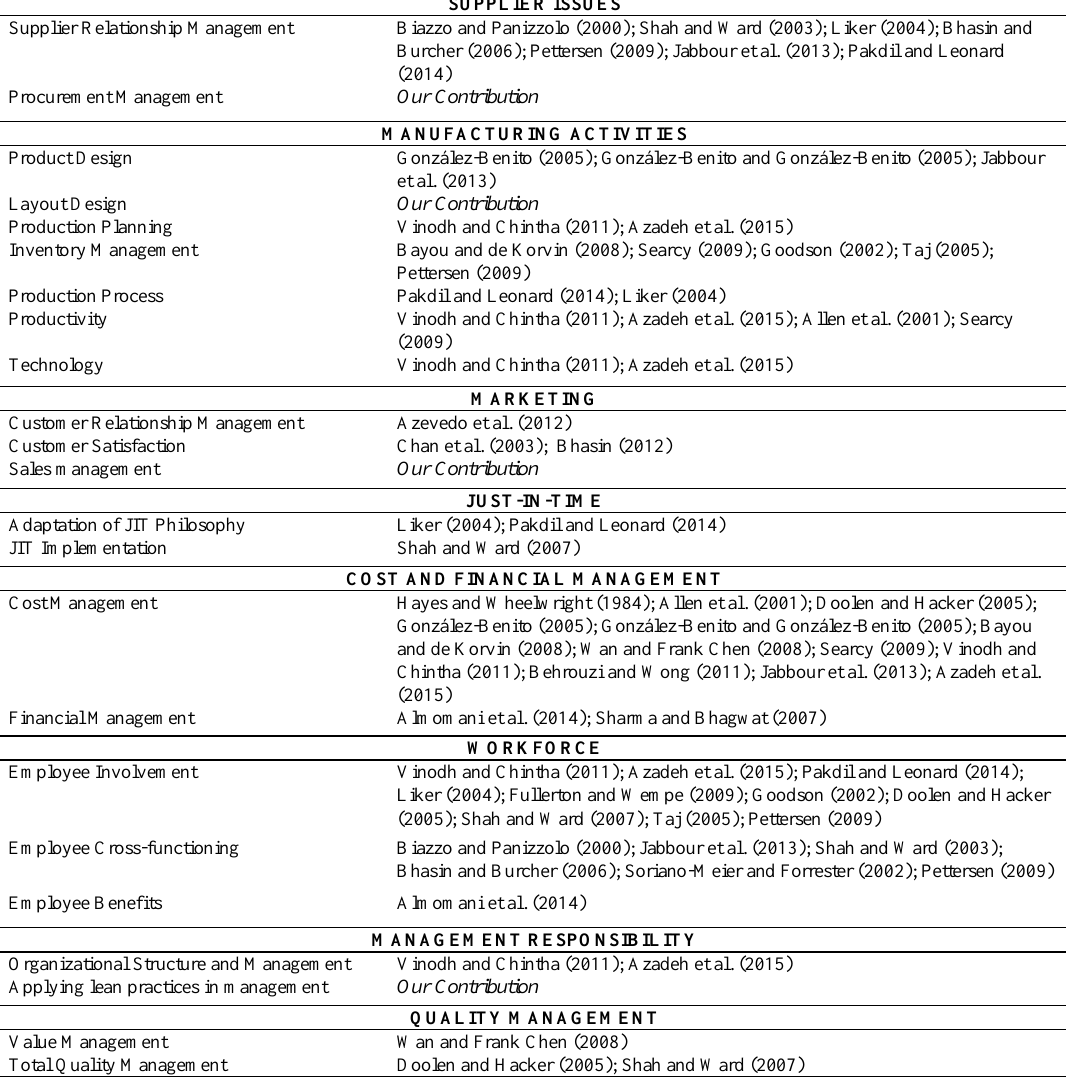
Table 2. Main criteria and sub-criteria for leanness assessment